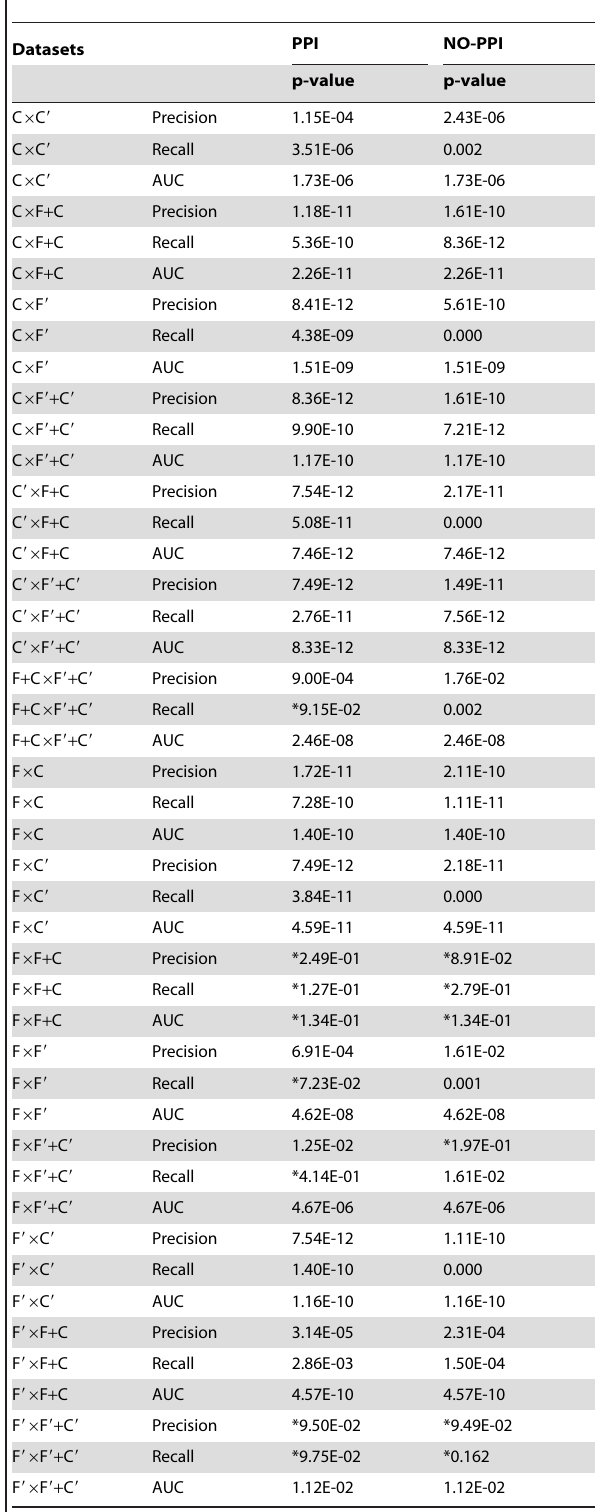
Table 1. Mann-Whitney U statistical test applied to performance measures of models generated from Normal training